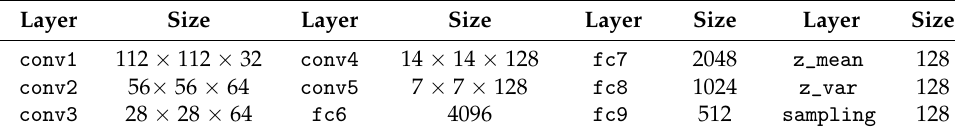
Table 1. The output shape of each layer in our VAE model.